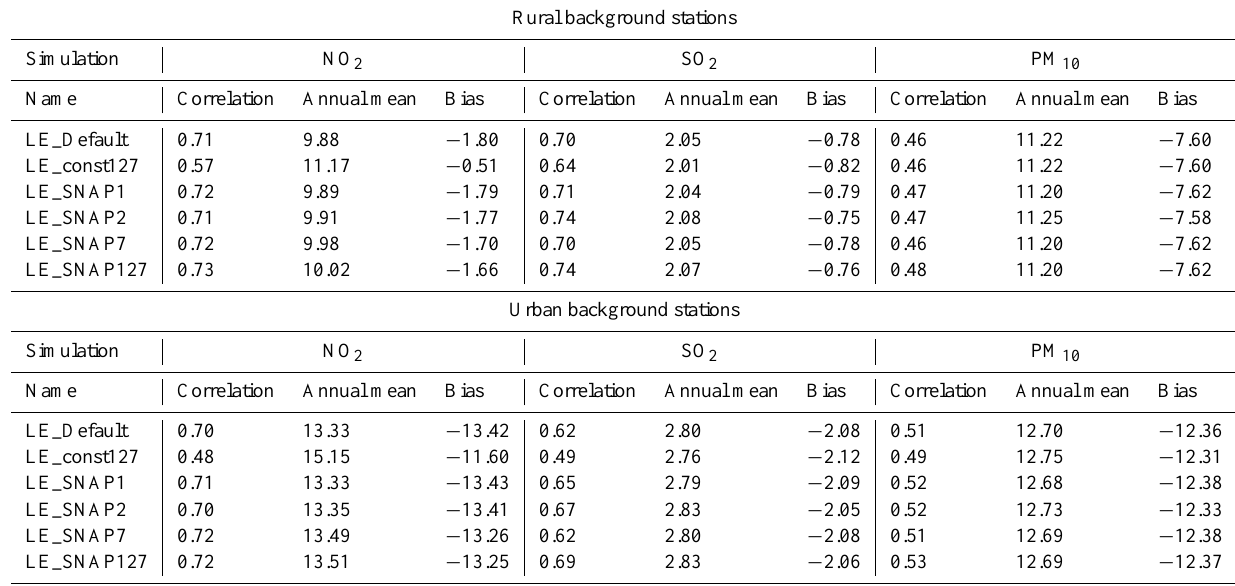
Table 3. Statistical overview of model performance averaged over all available stations based on hourly data. Thirty rural background stations and 48 urban background stations are included in the statistics. Annual mean and bias are given in µgm − 3 .